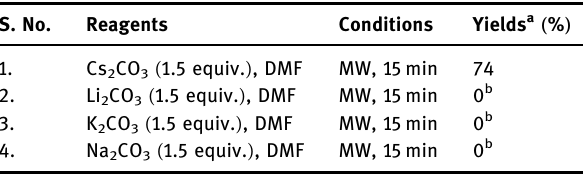
Table 2: Optimization of the reaction condition using other carbo